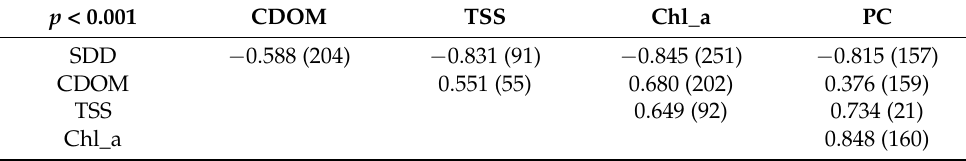
Figure 3. Boxplot of the values range for the water quality parameters. The box bounds the in- terquartile range (IQR; 25–75 percentile), the horizontal line inside the box indicates the median and whiskers (error bars) indicate the 90th above and 10th below percentiles. Dots indicate the outliers. Table 4. Spearman correlation coefficients, probability value and data points (in